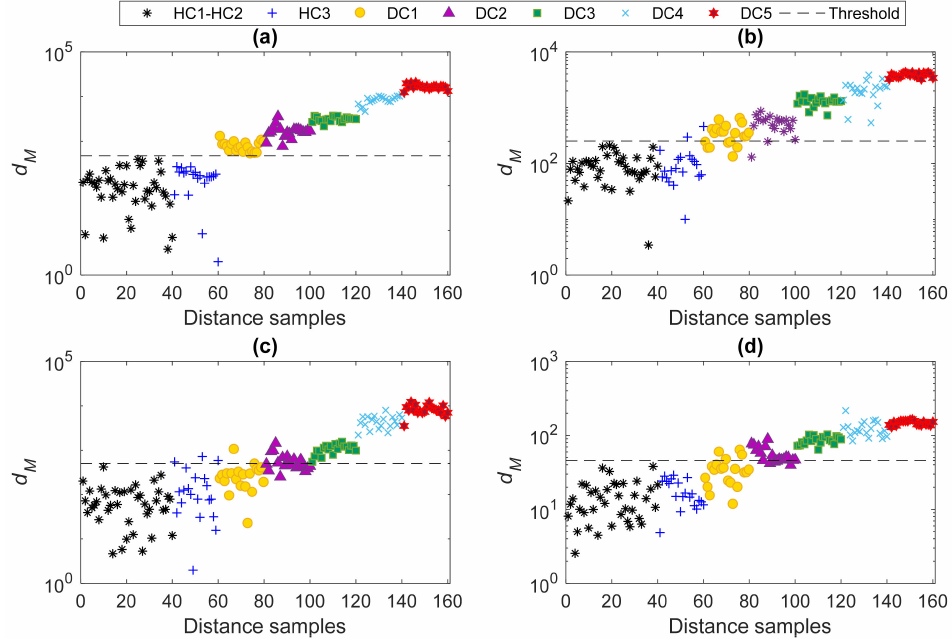
Figure 11. Damage detection by the conventional MSD technique and the AR coefficients: ( a ) Case 1, ( b ) Case 2, ( c ) Case 3, ( d ) Case